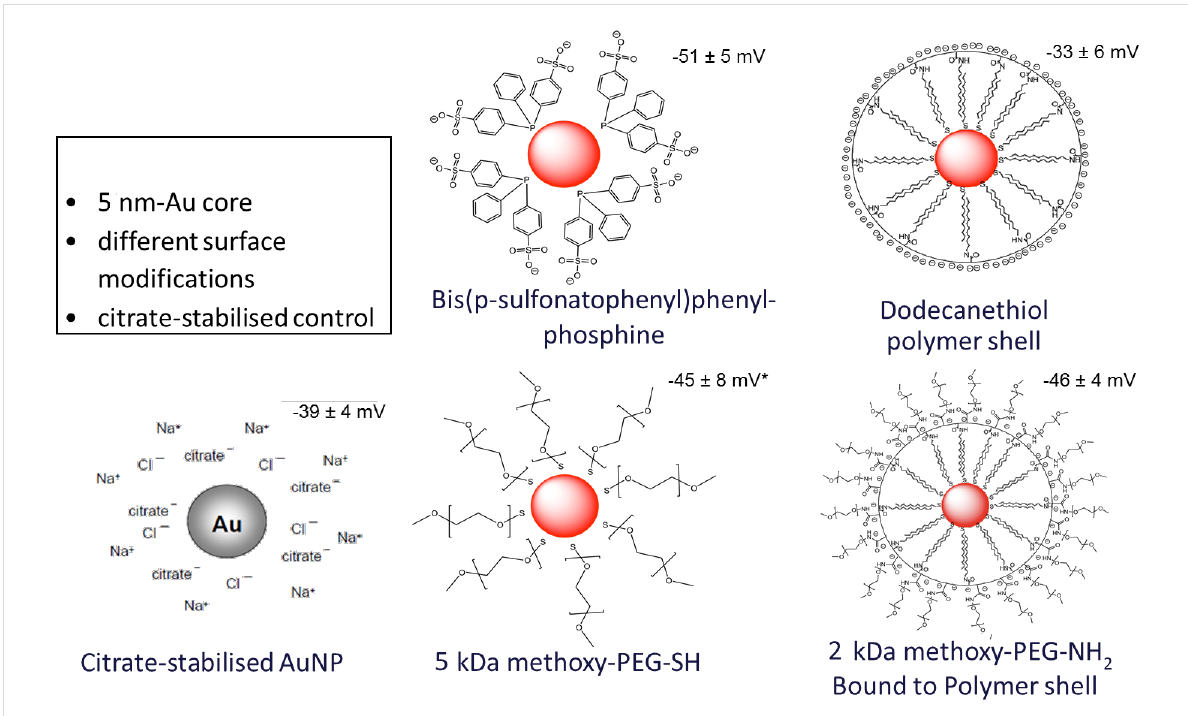
Figure 4: Spherical monodisperse AuNP of 5 nm core diameter with five different ligands. The zeta potential in millivolts is given for each NP.